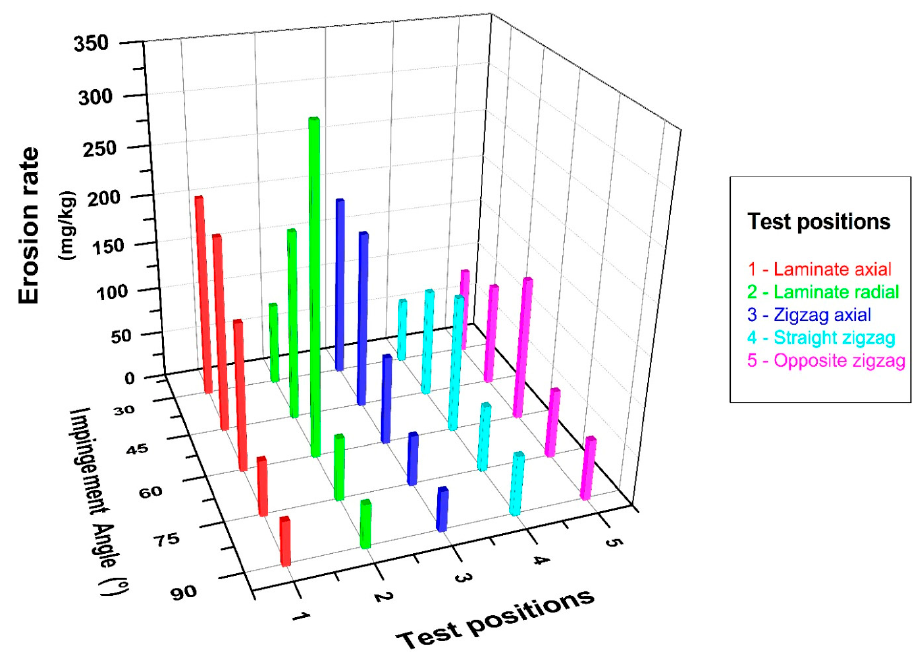
Figure 10. BFR/EP composite pipe outer surface radial and axial orientation erosion rate–impingement angle relationship.